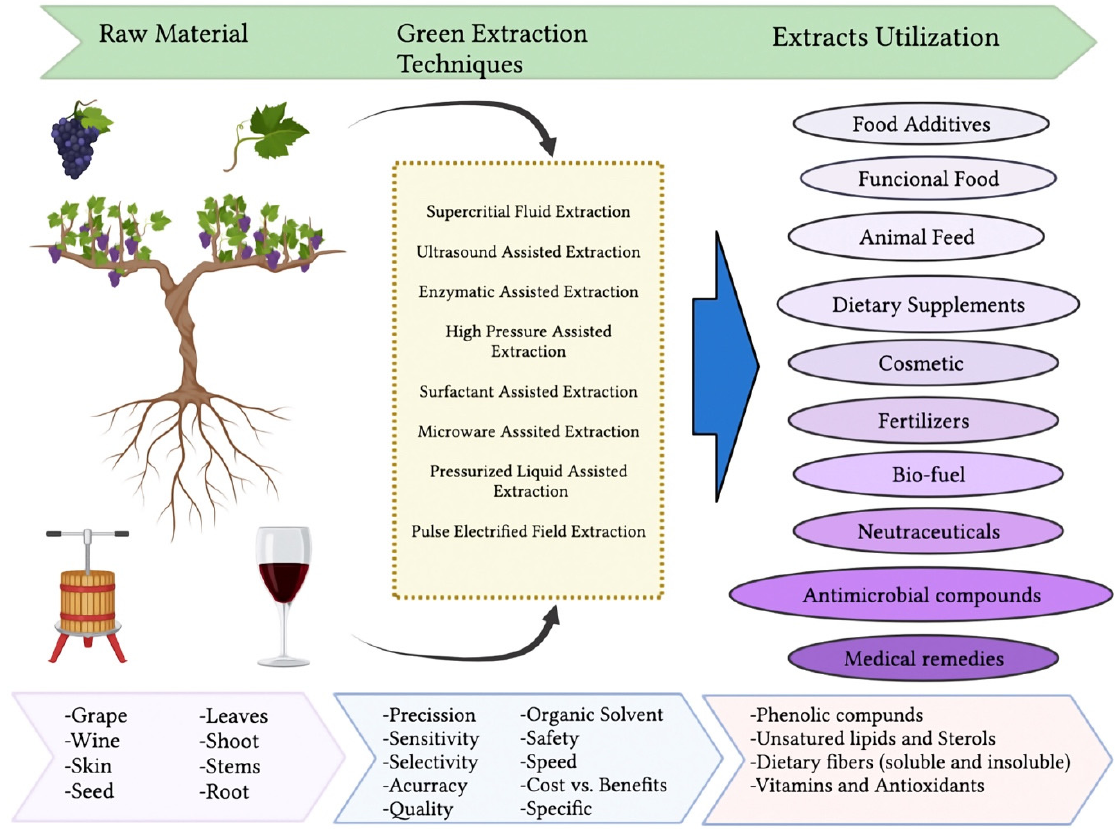
Figure 2. Green extraction techniques applied to by-products from the wine industry.